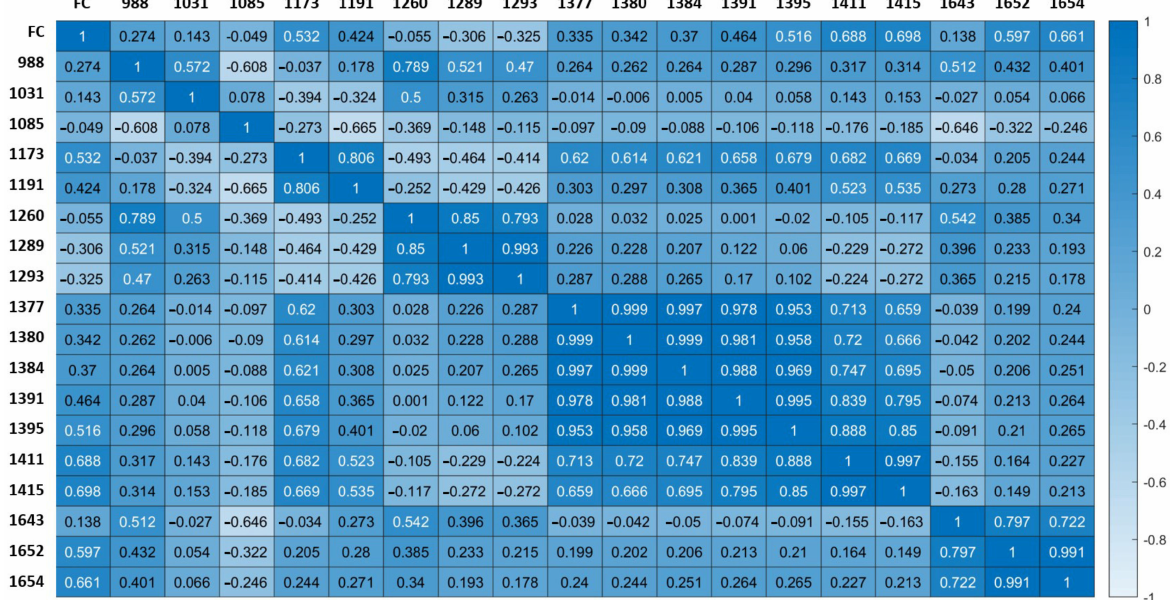
Figure 6. Heat map of the correlation coefficient between the selected characteristic wavelengths by IRIV and fat